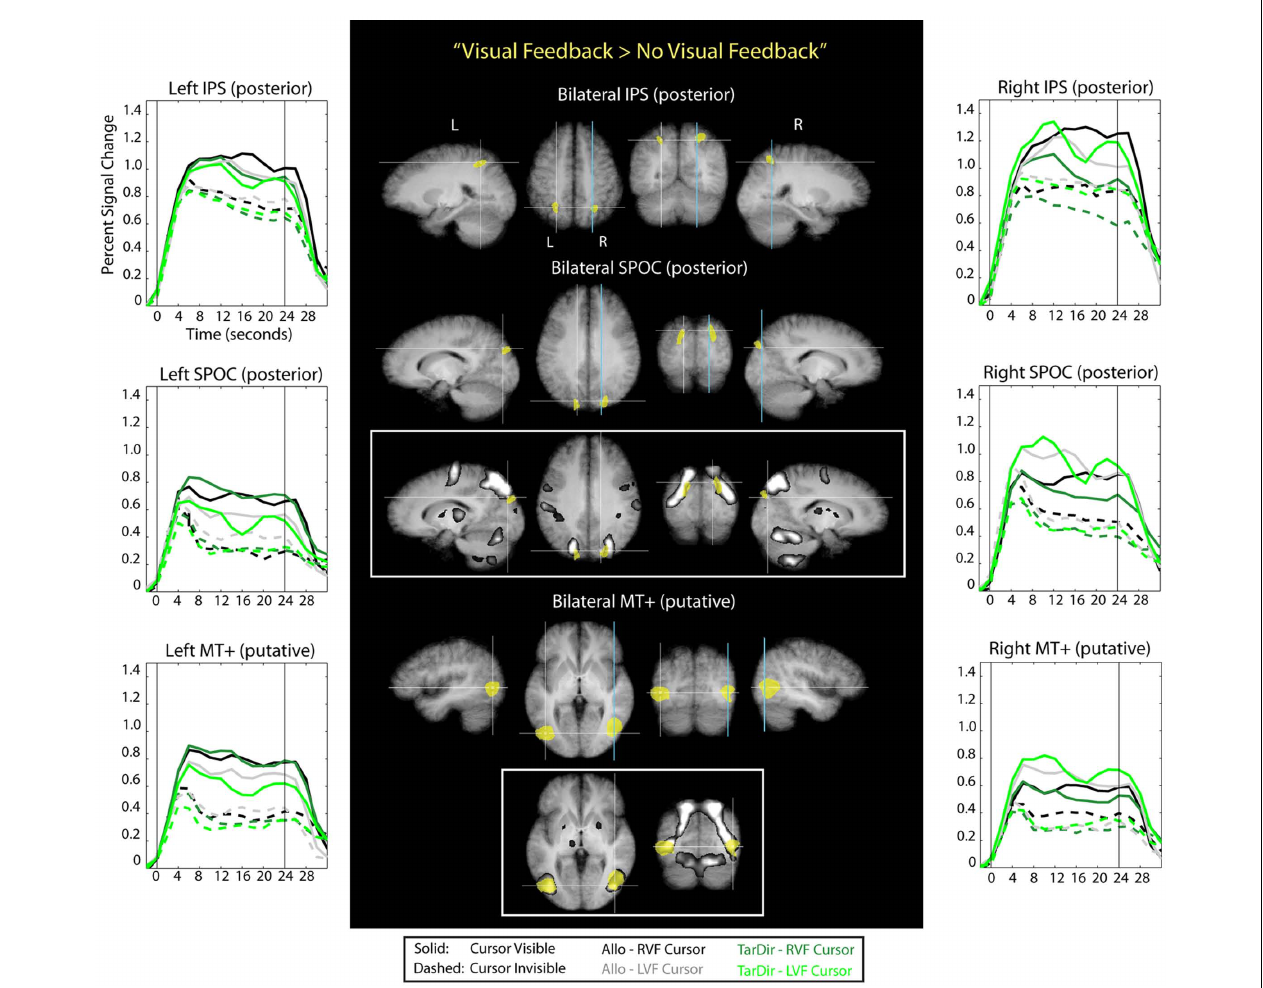
activation in middle temporal regions, superior parietal–occipital cortex (SPOC), and in posterior portions of the intra-parietal sulcus (IPS). Stereotactic coordinates of activation foci are provided in Table 3 . Insets illustrate the degree of overlap between “visual feedback areas” and the “shared sensory–motor network” (gray). No insets are provided for areas overlapped entirely by the “shared sensorimotor network.” Event related averages of regions depicted in yellow are shown as